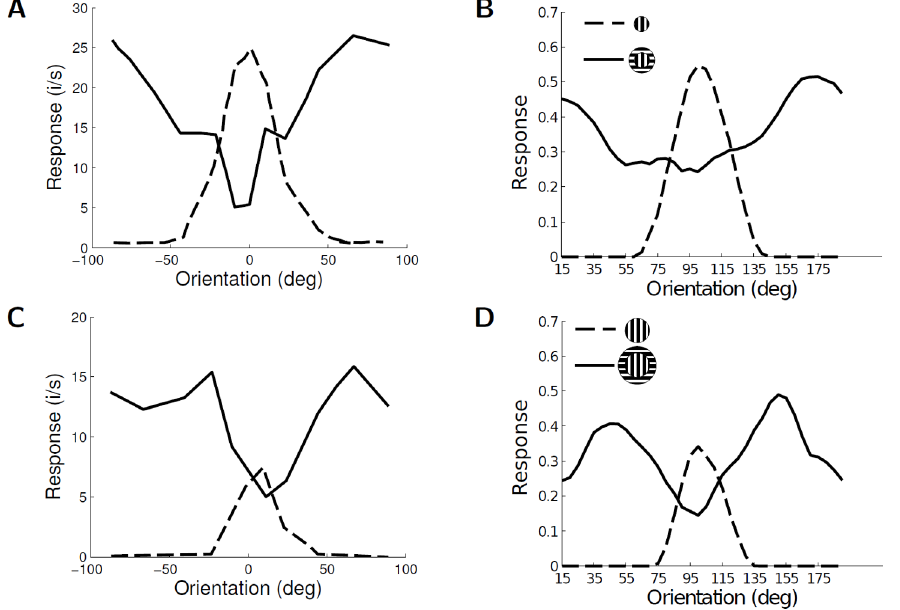
Figure 5. Orientation tunings for surround suppression and facilitation. (A) Center and surround tunings with the optimal stimulus center size in macaque V1 (data replotted from [41], Figure 2A). The center orientation tuning curve (dashed line) shows the cell’s response to a CRF sinusoidal grating. With the CRF stimulus fixed to an optimally-oriented grating, the surround orientation tuning curve (solid line) shows the cell’s response to a sinusoidal grating in the annular surround at various orientations. (B) A sparse coding model cell demonstrating similar surround orientation tuning properties, with highest levels of suppression at iso-oriented surround stimuli and almost no suppression for ortho-oriented surround stimuli. (C) Center and surround orientation tunings of the same cell as in (A) with the stimulus center size increased beyond the CRF and the width of the surround annulus unchanged (data replotted from [41], Figure 2B). (D) The same sparse coding model cell as in (B) demonstrates the facilitatory effects at ortho-oriented stimuli seen in